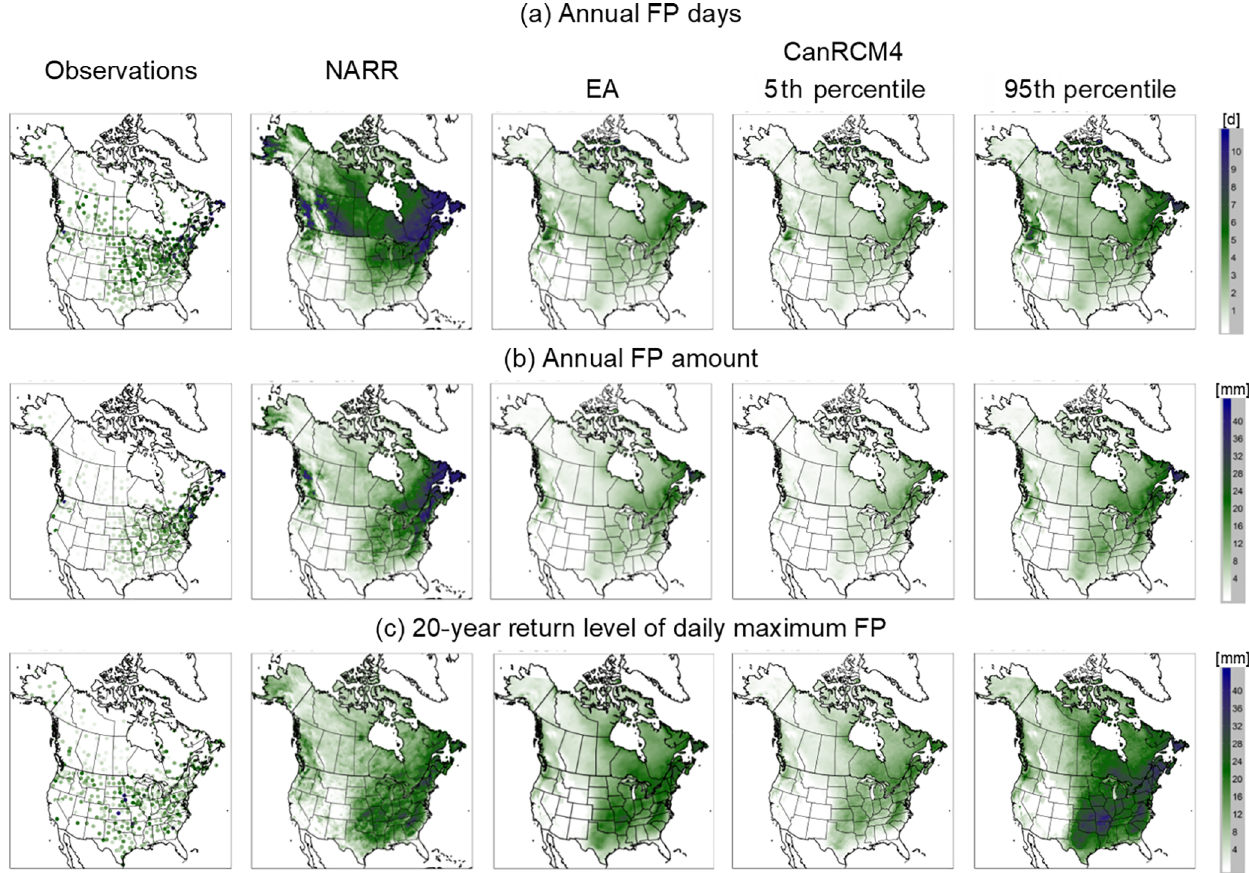
Figure 1. Mean values of (a) annual freezing-precipitation (FP) days and (b) total FP amount as well as (c) 20-year return levels of daily maximum FP for observations, NARR and CanRCM4 (ensemble average (EA) and 5th and 95th percentiles) for the baseline 1986–2016